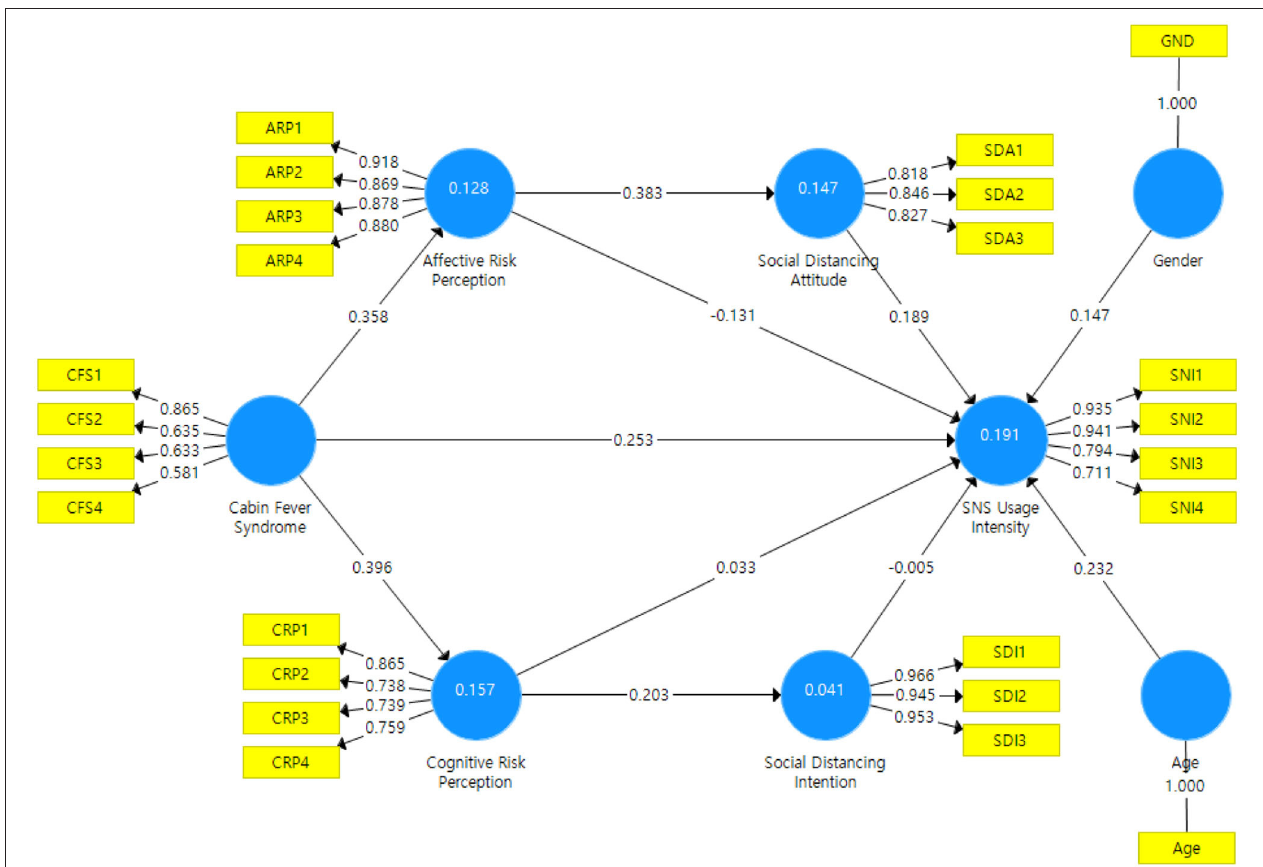
FIGURE 2 | Results of structural